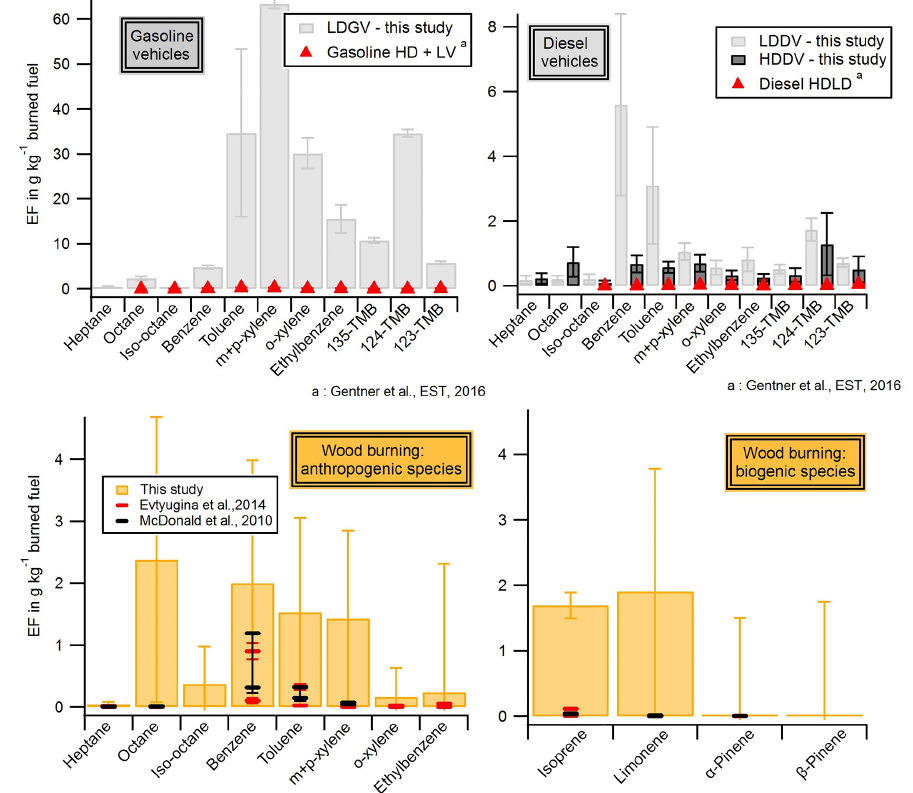
Figure 5. Comparison of VOC EF with the literature for traffic (light-duty gasoline vehicles, LDGV; light-duty diesel vehicles, LDDV; and heavy-duty diesel vehicles, HDDV) and wood burning. The bars correspond to the standard deviations of